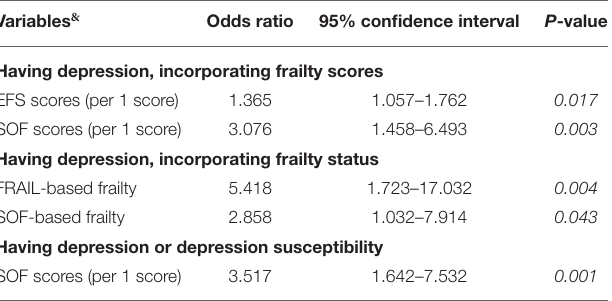
TABLE 3 | Independent factors associated with having depression among patients with end-stage renal